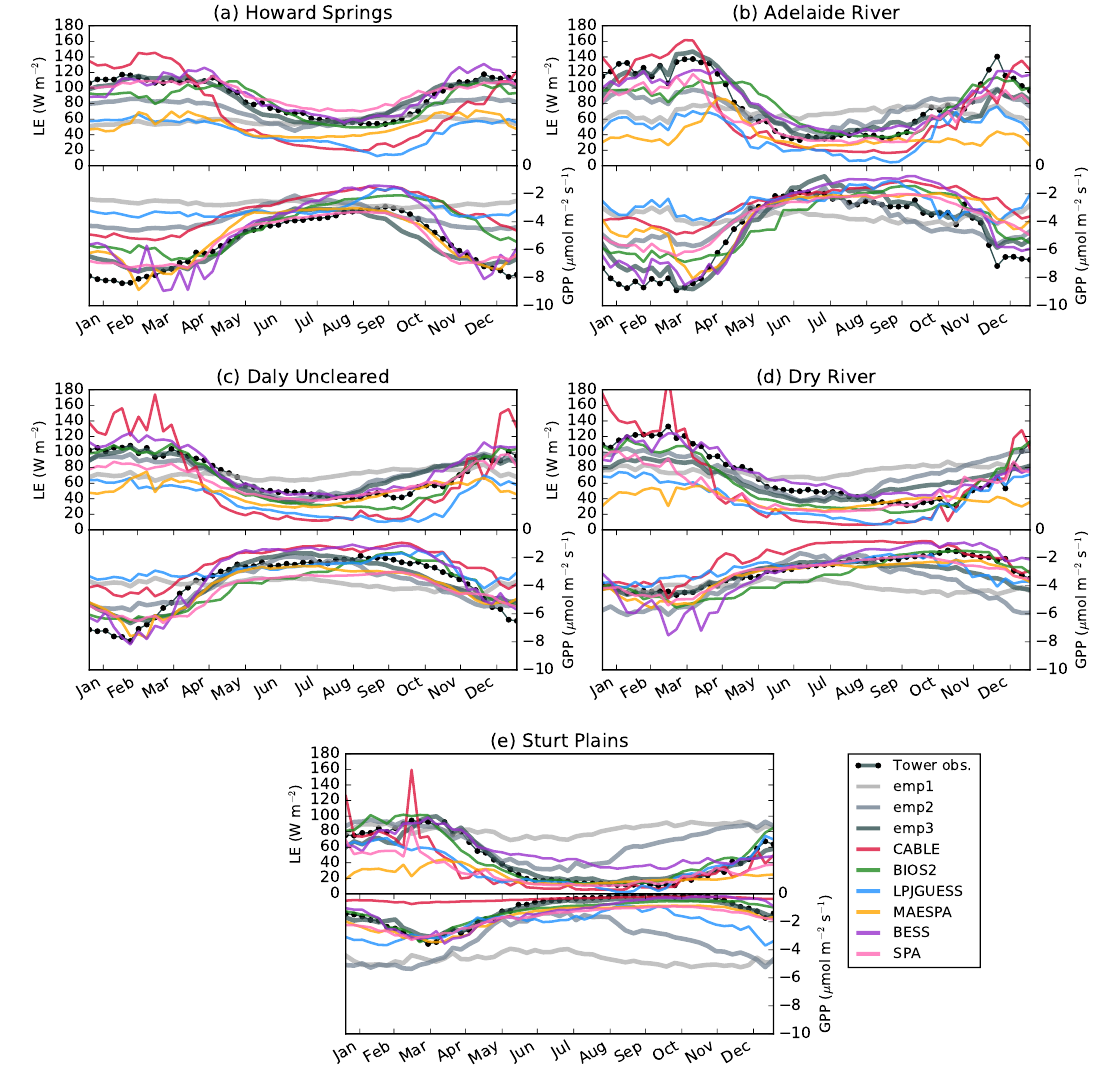
Figure 2. Time series of daily mean latent heat (LE) flux and gross primary productivity (GPP) depicting an average year for each of the five savanna sites using a smoothed, 7-day moving average. The sites are ordered from wettest to driest: (a) Howard Springs, (b) Adelaide River, (c) Daly River, (d) Dry River, and (e) Sturt Plains. The joined black dots are the tower flux time series, while the grey lines are the performance benchmarks (emp1, emp2, emp3). Predictions of LE and GPP for each of the six terrestrial biosphere models are given by a spectrum of colours described in the